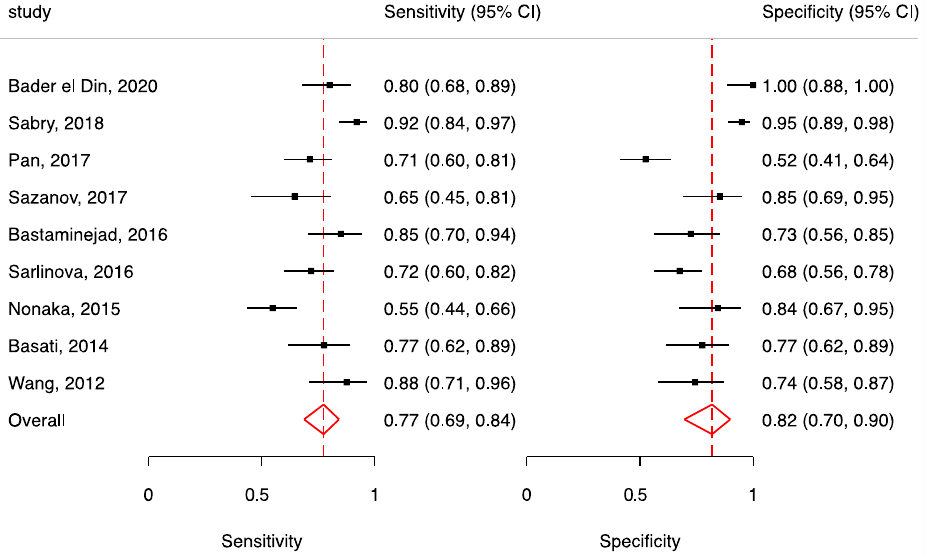
Figure 3. Forest plot of included studies assessing the sensitivity and specificity of miR-21 in CRC diagnosis (squares show sensitivity and specificity, respectively; red diamonds show pooled effect; error bars represent 95% confidence interval) Bader El Din, 2020 [19], Sabry, 2018 [21], Pan, 2017 [36], Sazanov, 2016 [38], Bastaminejad, 2017 [37], Sarlinova, 2016 [42], Nonaka, 2015 [45], Basati, 2014 [52], Wang, 2012 [55].